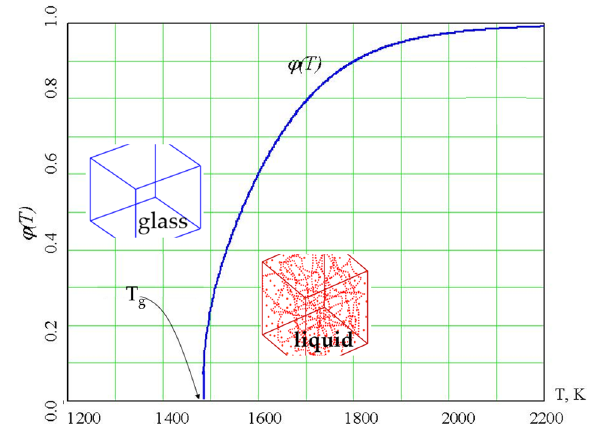
Figure 4. The order parameter of configurons ϕ (T) in amorphous SiO 2 . Configurons occur in the glass as point defects, whereas in the liquid phase (above the T g ), they form macroscopic percolating clusters, as schematically shown by the insets.